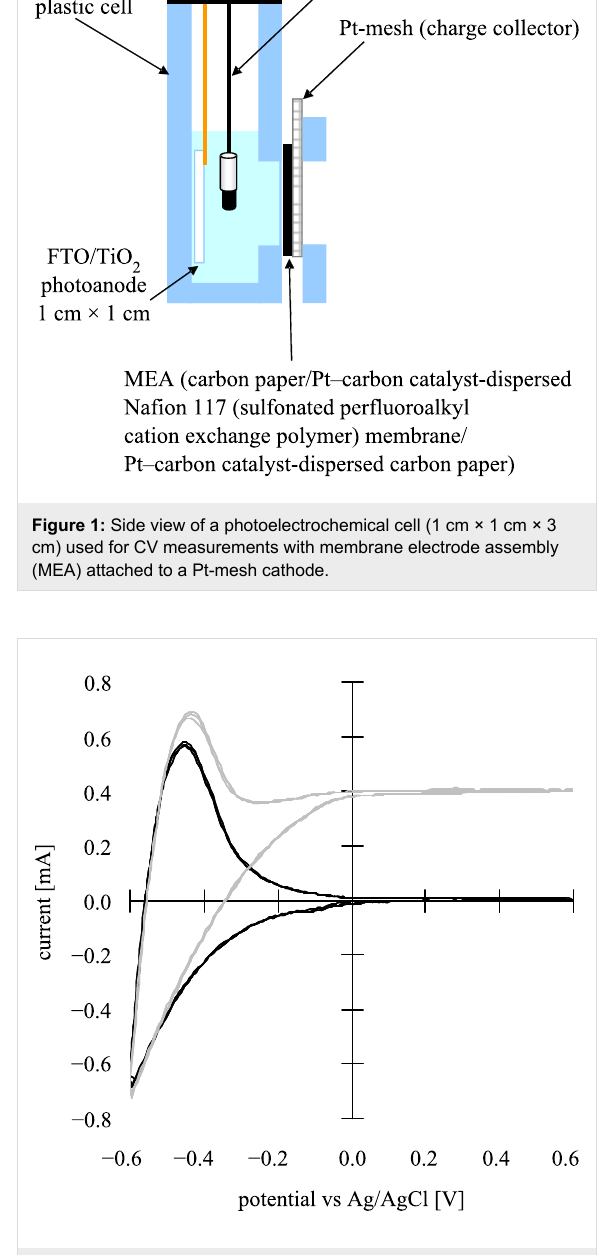
Figure 2: Cyclic voltammograms both in the dark (black line) and with light irradiation (gray line) at a nanoporous TiO 2 photoanode (1cm x 1cm) in an aqueous solution of 10 wt % methanol (+ 0.1 M Na 2 SO 4 , pH 8.5) under an Ar atmosphere with MEA-attached Pt (1 cm × 1 cm) as the counter electrode and Ag/AgCl as the reference electrode. The light intensity was 3.5 mW·cm − 2 (UV-A region). Scan rate: 100 mV·s − 1